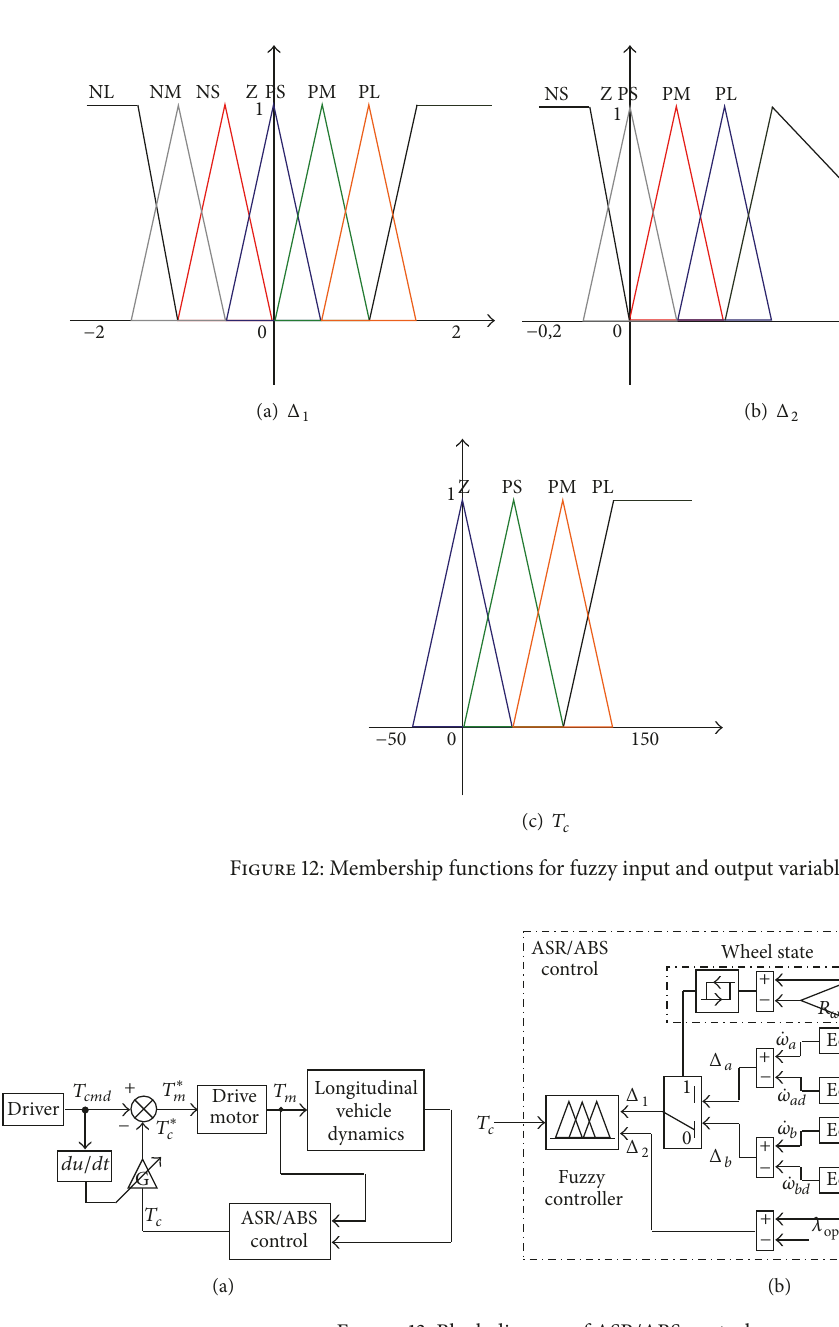
Figure 13: Block diagram of ASR/ABS